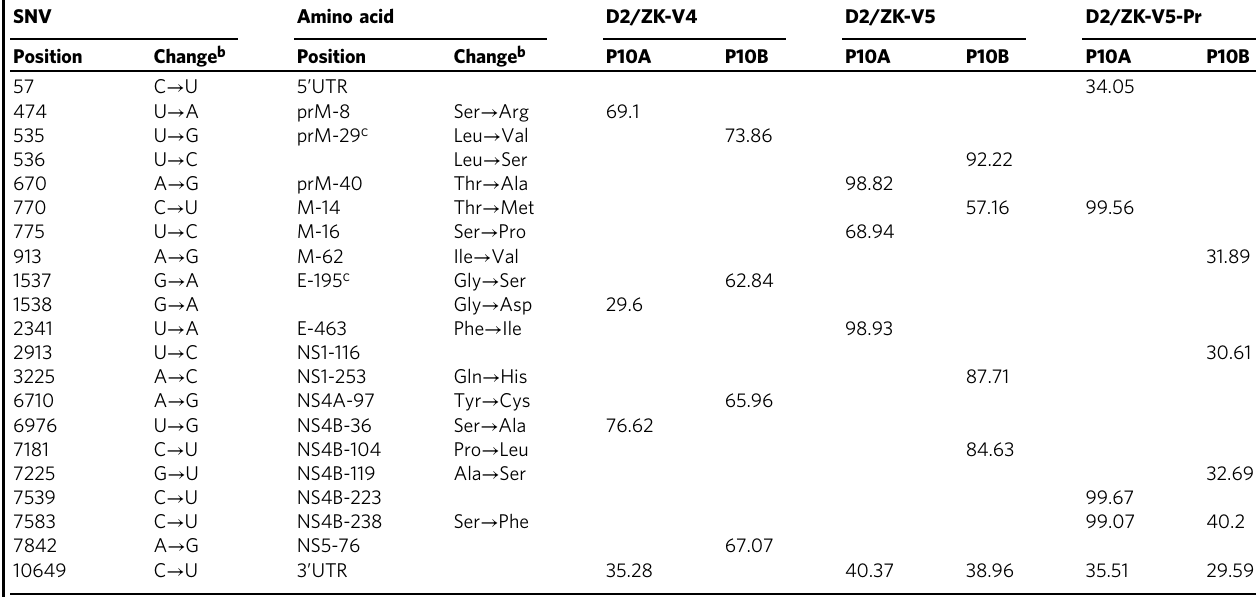
Table 1 Single nucleotide variants (SNVs) with frequencies a ≥ 25% in P10